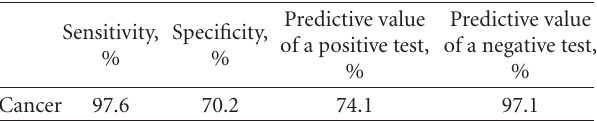
Table 2: Results of statistical analysis of detection of colon biopsies by FT-IR